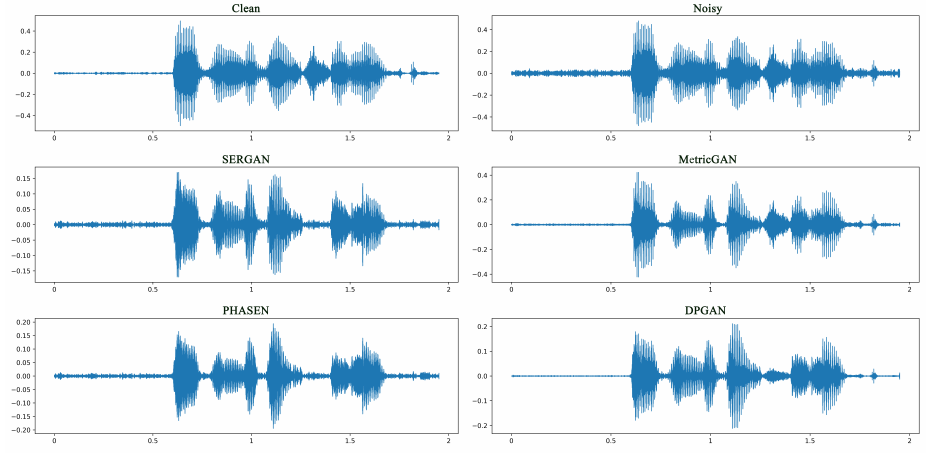
Figure 8. A comparison of the waveforms of the enhancement effect for full-band noise at lower signal-to-noise ratios is shown. Noise appears as cluttered pulses in